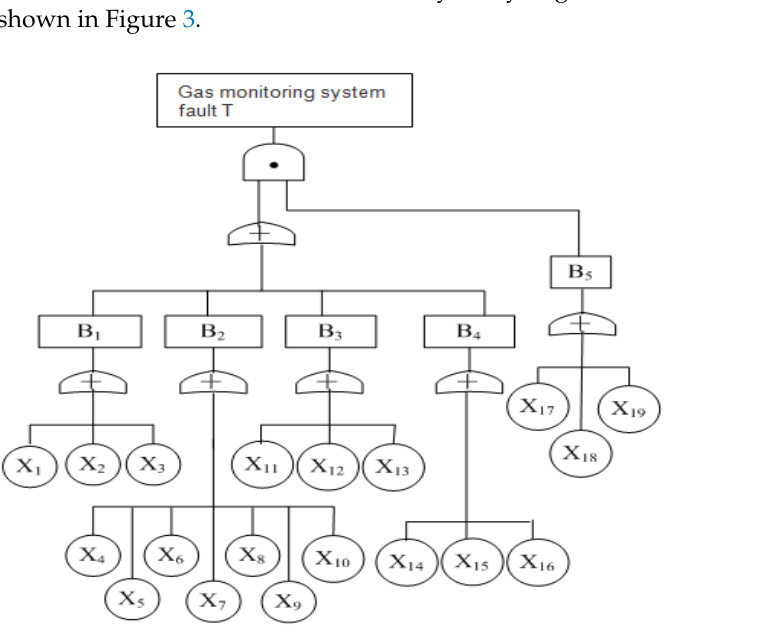
Figure 3. Fault tree of a gas monitoring system.